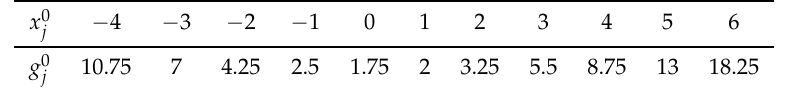
Table 6. Convex data set of